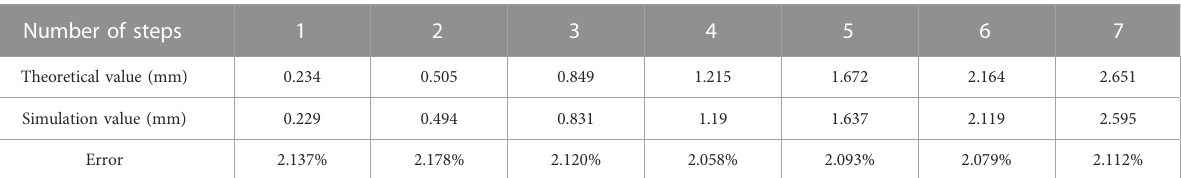
TABLE 4 Equivalent pressure loading error analysis.